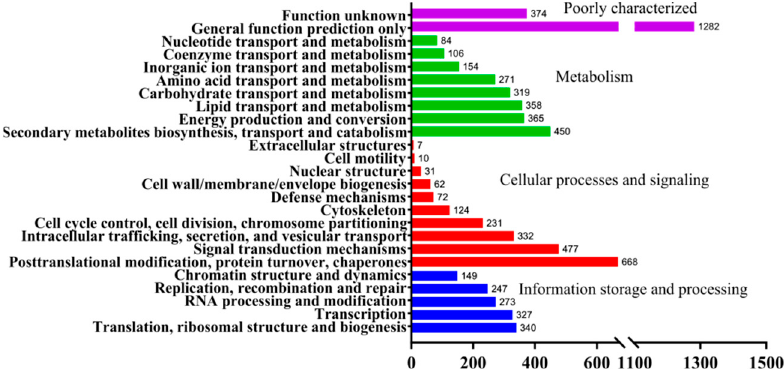
Figure 3. Genes functional classification of yw-1-5 by KOG.